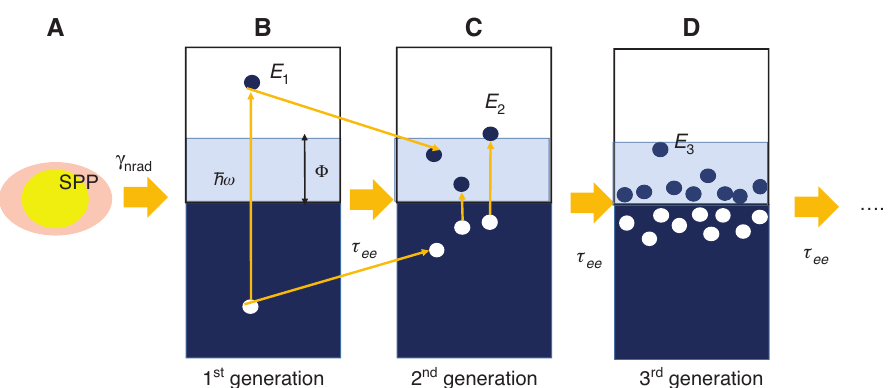
Figure 8: Quantum picture of carrier generation and relaxation in metal nanoparticles. (A) An SPP is excited on a nanoparticle. (B) An SPP has decayed, engendering a primary (first-generation) electron-hole pair. (C) Each of the first-generation carriers decays into three second-generation carriers. (D) Each of the second-generation carriers decays into three third- generation